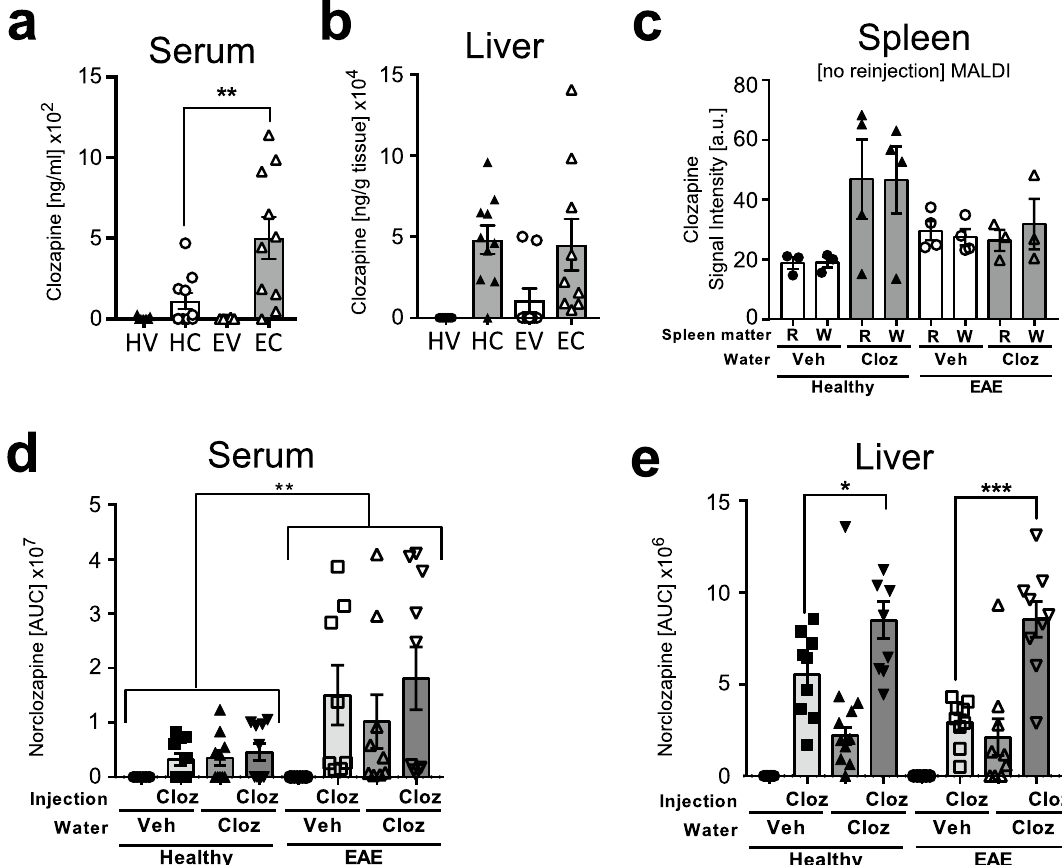
Figure 3. Clozapine and norclozapine quantification in the serum and liver and clozapine intensity in the spleen by MALDI . (a,b) Mice were treated with clozapine or vehicle 1 day prior to EAE induction in the drinking water and absolute clozapine concentration measured by LC–MS was analysed in the serum (a) and liver (b) (n = 10 mice/group), two-way ANOVA repeated measure followed by Sidak’s multiple comparison test, ** p > 0.01; (c-e) Mice were treated with clozapine or vehicle 1 day prior to EAE induction in the drinking water and clozapine signal intensity by MALDI IMS was analysed in the spleen, separated by red and white matter (n = 4–5 mice/group) (c) and norclozapine concentration measured by LC–MS was analysed in the serum (d) and liver (e) (n = 10 mice/group) in healthy and EAE mice treated with clozapine in the drinking water and reinjection of clozapine, two-way ANOVA repeated measure followed by Sidak’s multiple comparison test, *p > 0.05; **p > 0.01; ***p >